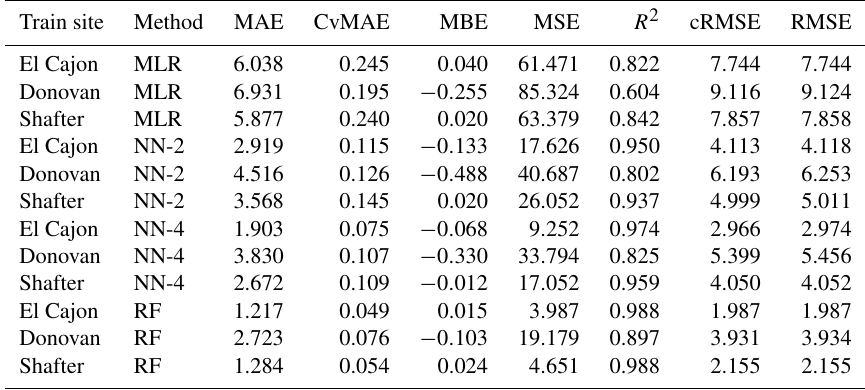
Table C7. Level 1 train results for O 3 (train and test on the same data